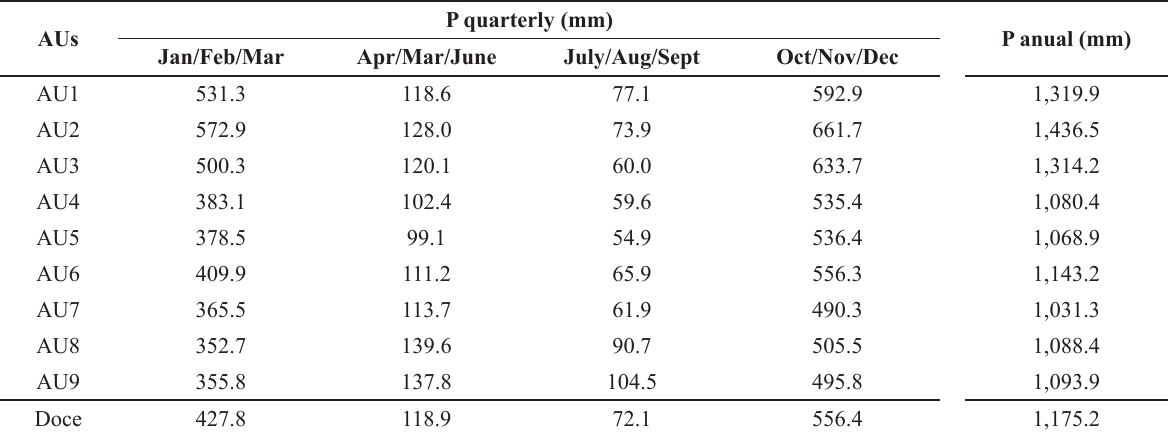
Average quarterly and annual precipitation, in mm, of the analysis units (AUs) and of the catchment area of the Doce